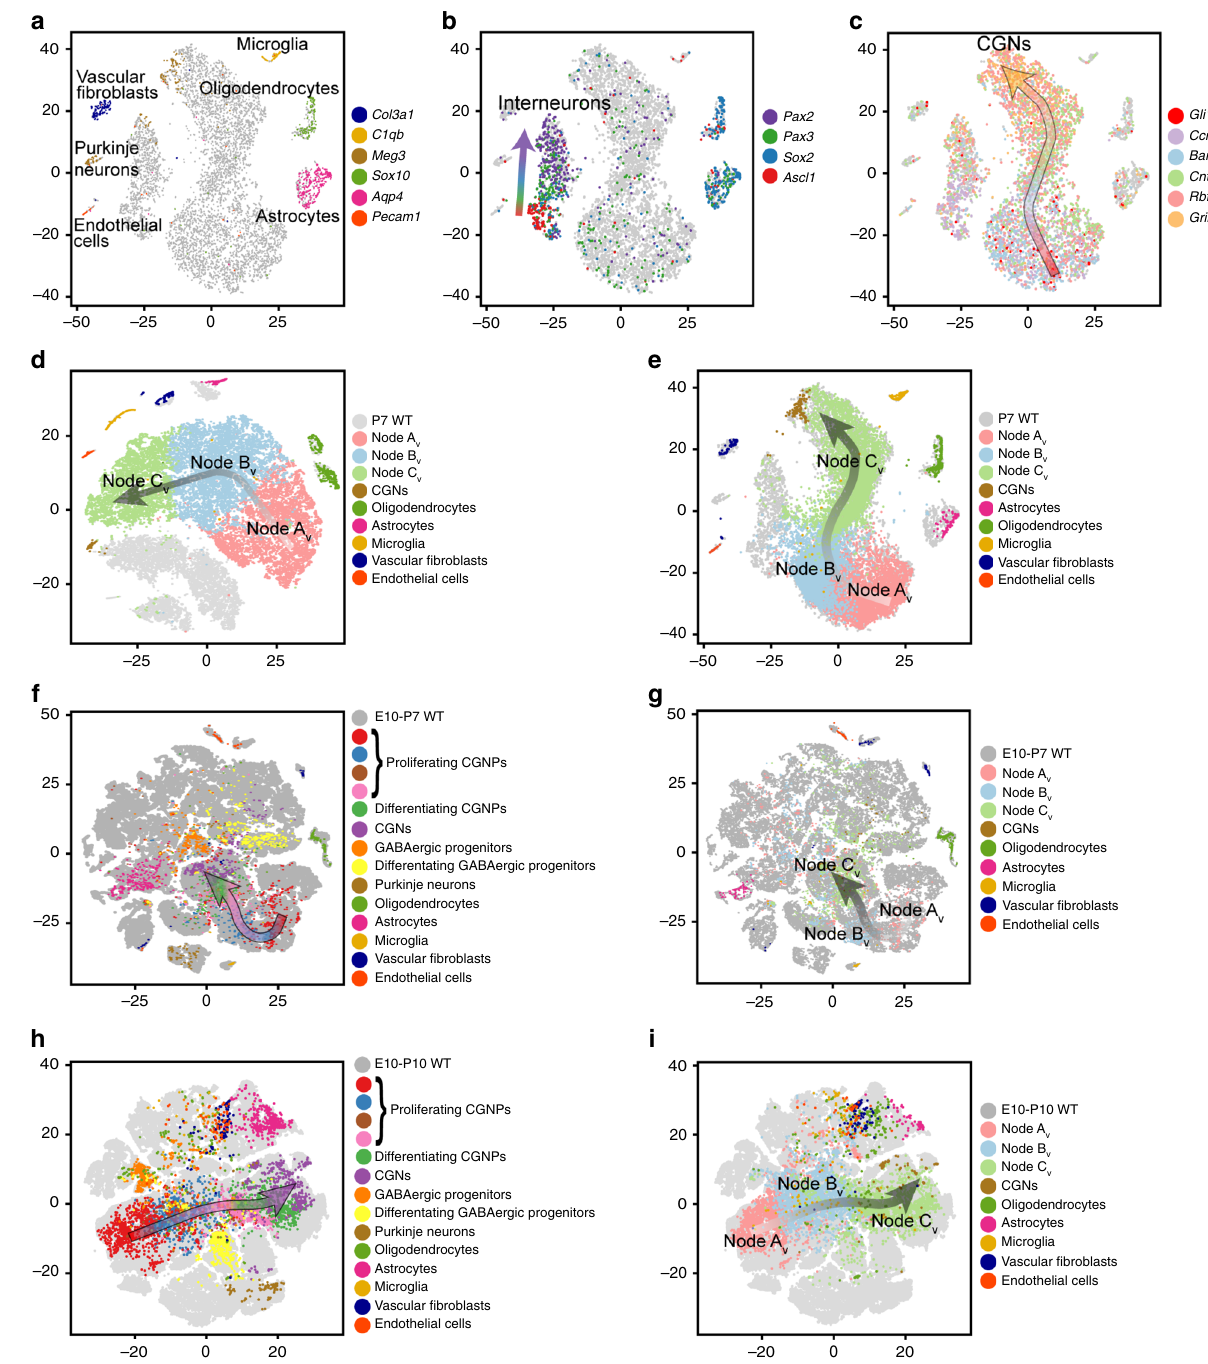
Fig. 3 The tumor cells projected on WT P7 cerebellum predominantly map to CGNPs. a t-SNE projection of cells from fi ve WT P7 cerebella, based on PCA, color-coded for the expression of indicated vascular, microglial and glial markers. b Feature plot of Pax2 , Sox2 , Pax3 , Ascl1 on the t-SNE projection in a . c Feature plot of CGNP markers Gli1 , Ccnd2, Barhl1, Cntn2, Rbfox3, Grin2b on the t-SNE projection in a . d Seurat CCA analysis of M-Smo and WT cells with co-clustering of stromal cell types and no co-clustering of Nodes A V – C V . e Cells from the fi ve vehicle-treated M-Smo tumors, mapped using the k-NN algorithm onto the WT P7 cerebella t-SNE projection in a , with Nodes A V – C V and identi fi ed cell types color coded. f , h P7 WT cells mapped by kNN